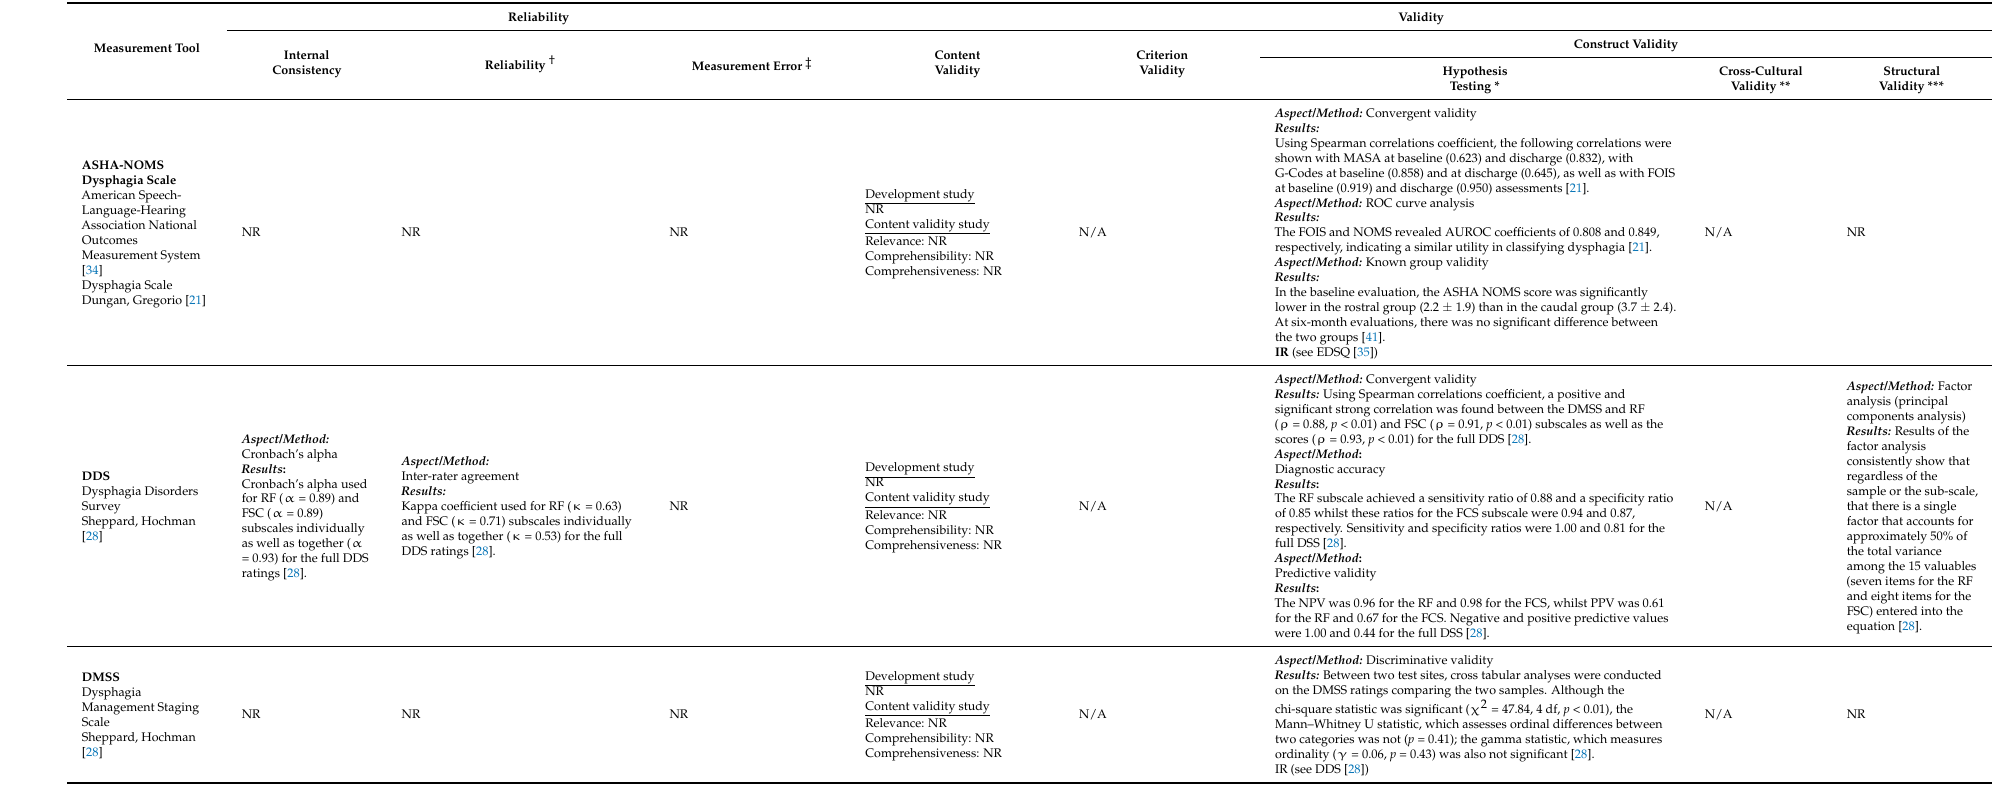
Table 3. Psychometrics reported for